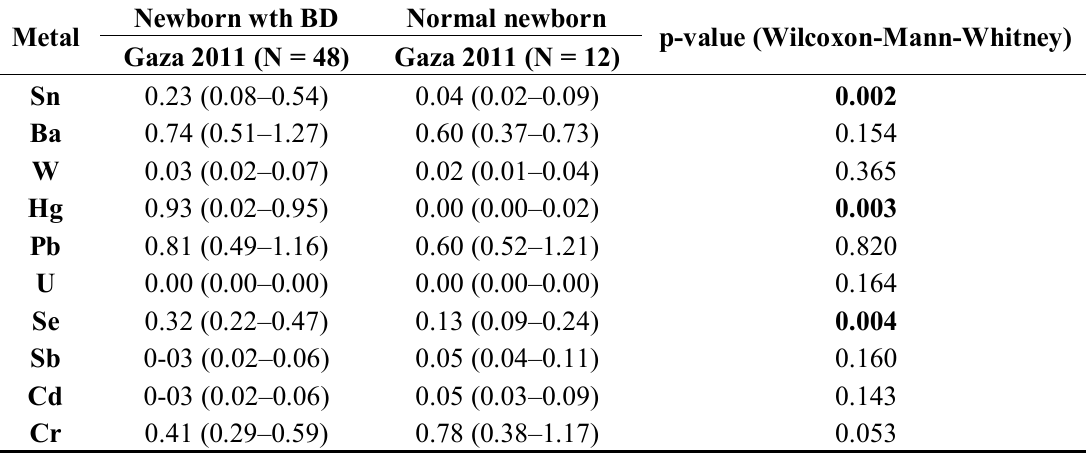
Table 1. Comparison of metal load (ppm) between newborn with birth defects (N = 48) and normal (N = 12). Difference in metal concentrations between groups was assessed by Wilcoxon-Mann-Whitney test. Interquartile range in brackets.